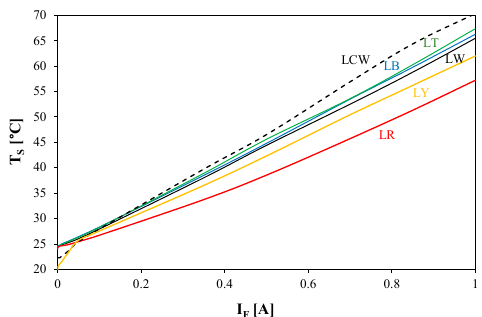
Figure 10. Measured dependences of the temperature of the soldering point T S of the tested power LEDs on forward current.